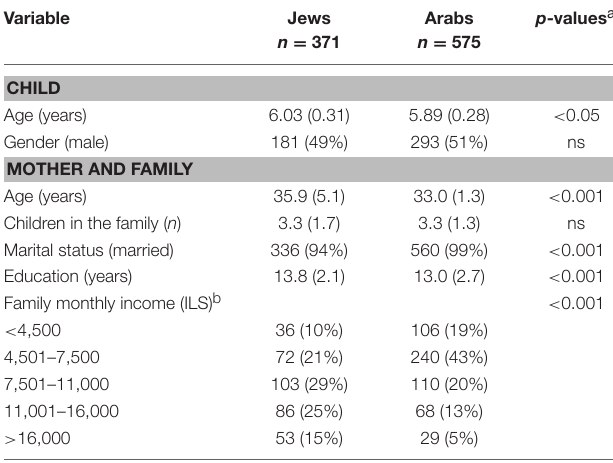
TABLE 1 | Demographic background variables in the Jewish and Arab population